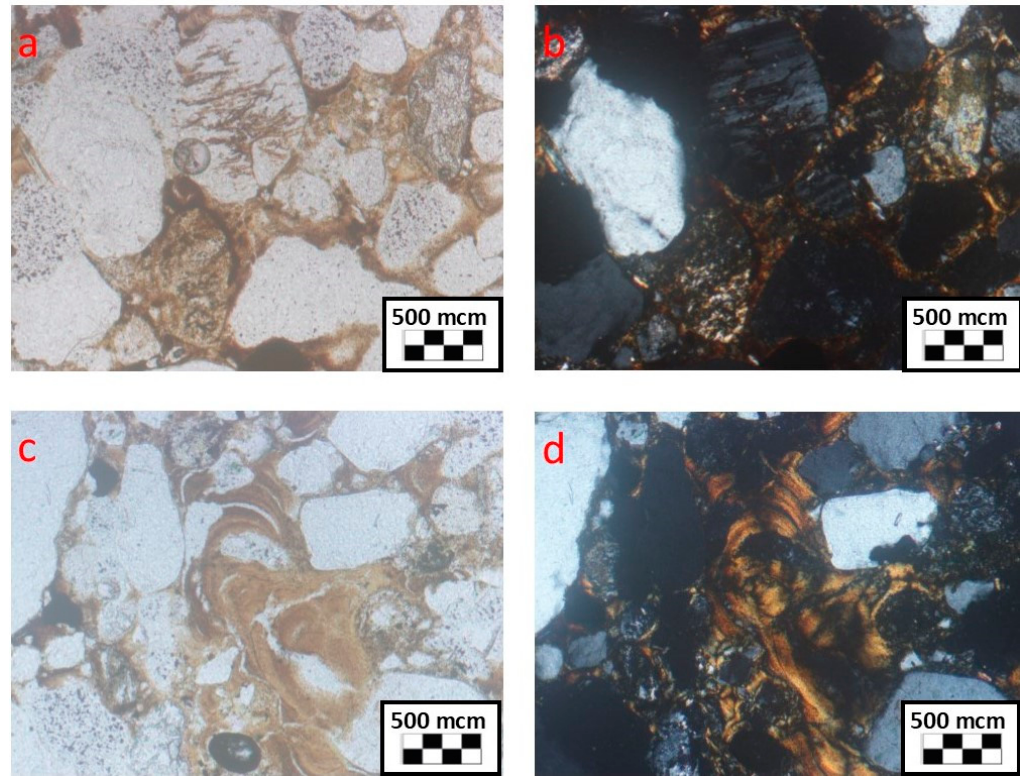
Figure 8. Micromorphological features of the upper part of Bwb horizon (Paleosol 2): ( a , b ) clay coating and bridges (PPL and XPL, respectively); ( c,d ) two phases of clay illuviation (centre): limpid yellow-brown clay coating (older) and dusty brown clay coating with ferruginous hypocoatings (possibly younger) (PPL and XPL, respectively).